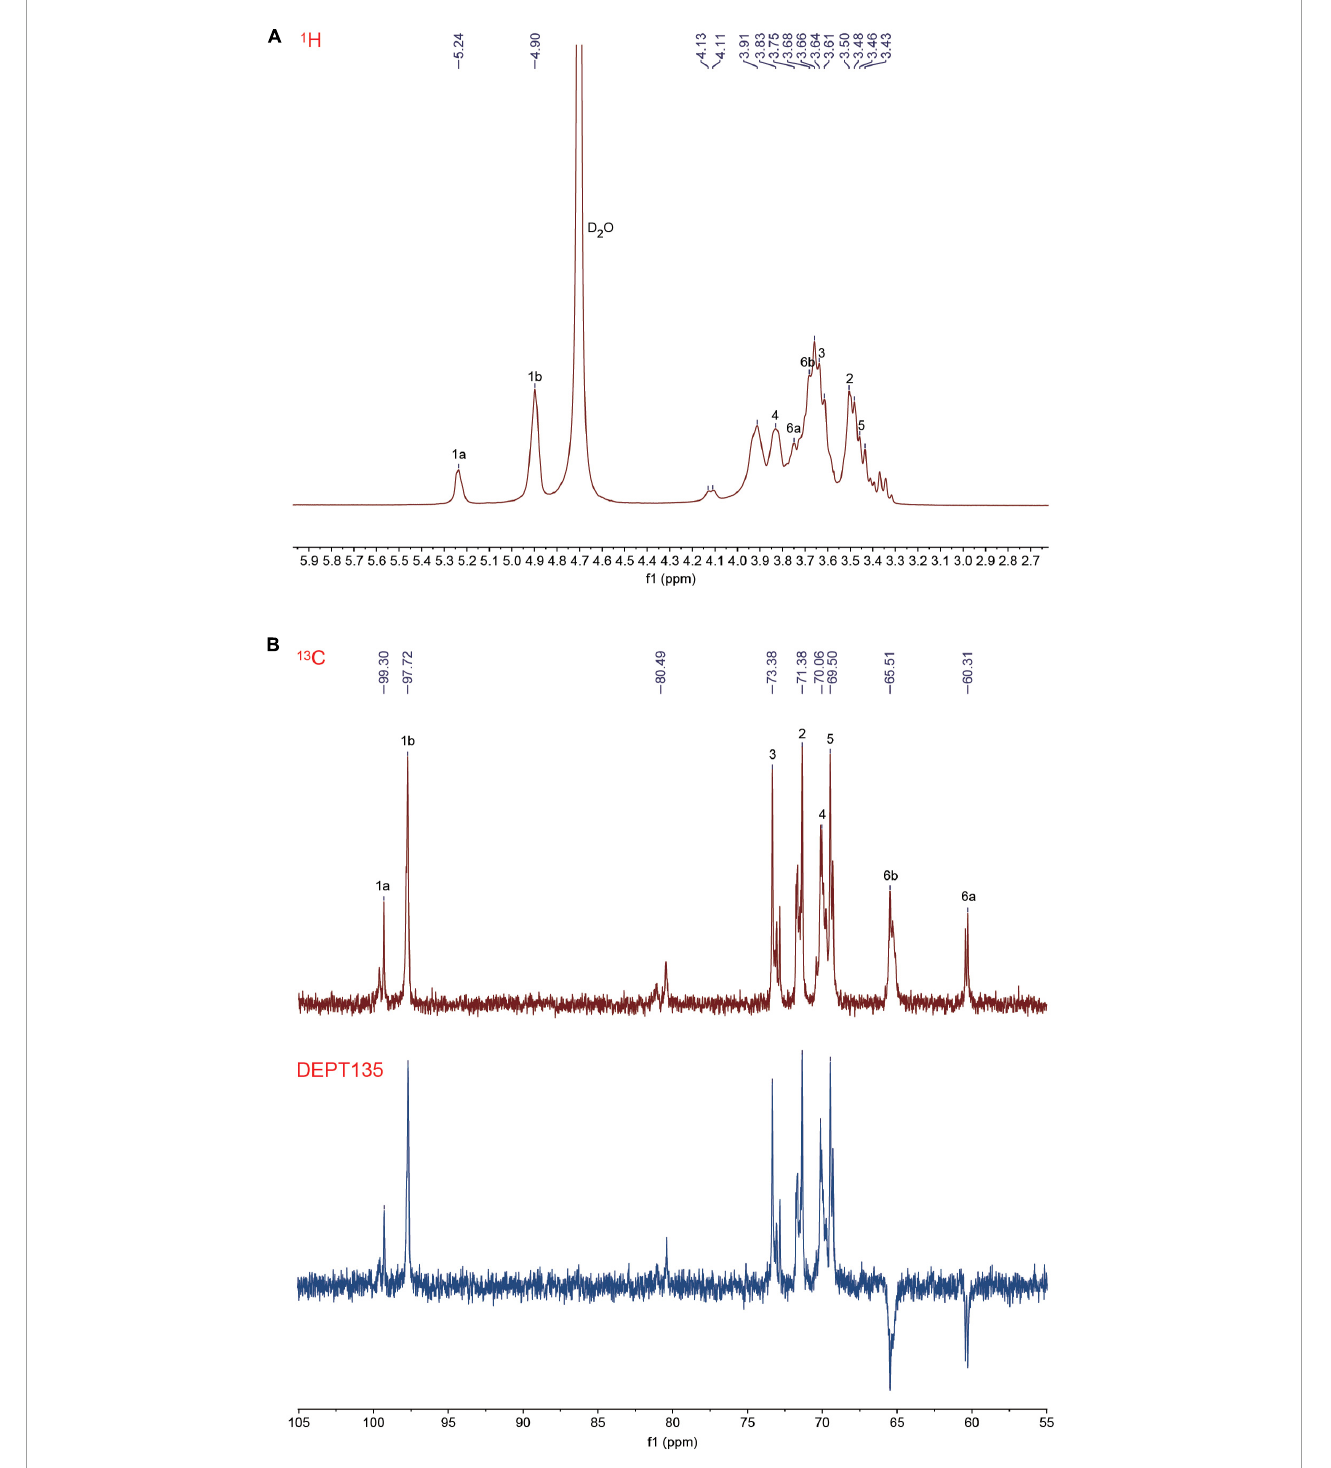
FIGURE3 One-dimensional nuclear magnetic resonance (NMR) spectra of Leu. mesenteroides RSG7 exopolysaccharide (EPS). (A) 1 H and (B) 13 C and